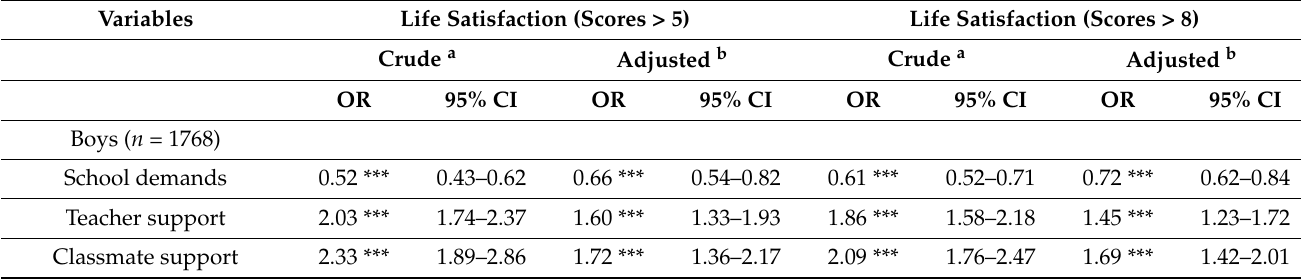
Table 4. Odds ratios and 95% confidence intervals from binary logistic regressions of life satisfaction, stratified by gender and age,